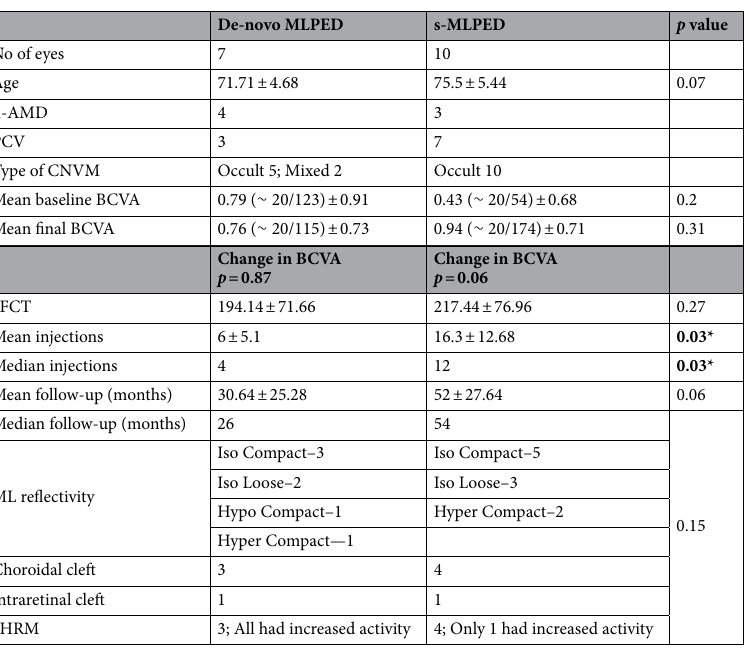
Table 2. Comparison between de-novo MLPED and s-MLPED features. MLPED: multilayered pigment epithelial detachment; s-MLPED: secondary multilayered pigment epithelial detachment; n-AMD: Neovascular age-related macular degeneration; PCV: Polypoidal choroidal vasculopathy; CNVM: Choroidal neovascular membrane; BCVA: Best corrected visual acuity; SFCT: Sub-foveal choroidal thickness; ML: Multilayer; SHRM: Subretinal hyperreflective material; CFCF: Counting finger close to face; CF: Counting fingers. *Statistically